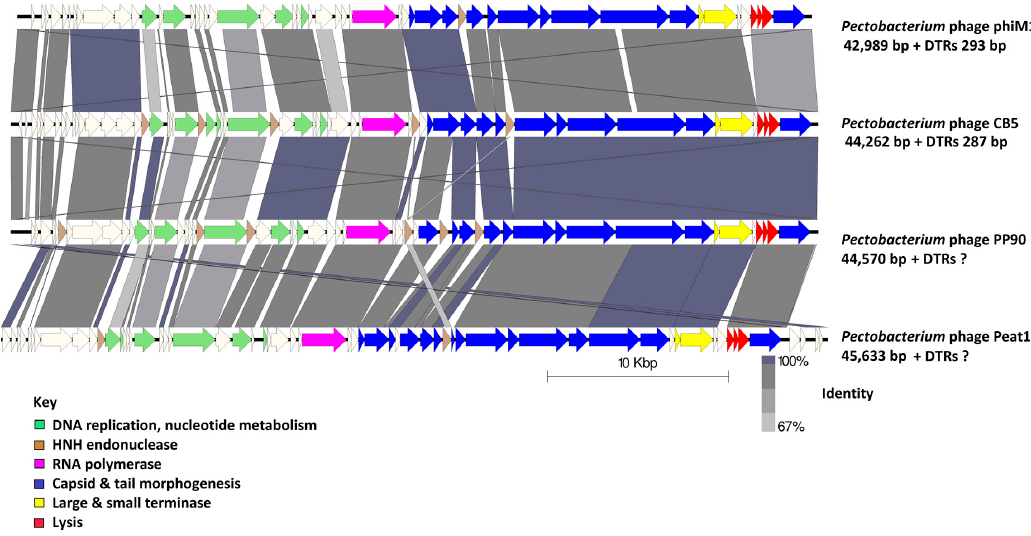
Figure 3. Comparison of the genomes of the phages that form the proposed genus of ‘ Phimunavirus ’. Pectobacterium phage CB5 and Pectobacterium phages φ M1, Peat1, and PP90 are shown using currently available annotations from Genbank, employing BLASTN and visualization with Easyfig. The genome maps display arrows indicating locations and orientation of ORFs among different phage genomes. Arrows have been color-coded describing their predicted roles (see key), and shading between the genome maps indicates the level of identity. Phage DTRs of unknown length marked with “?”.